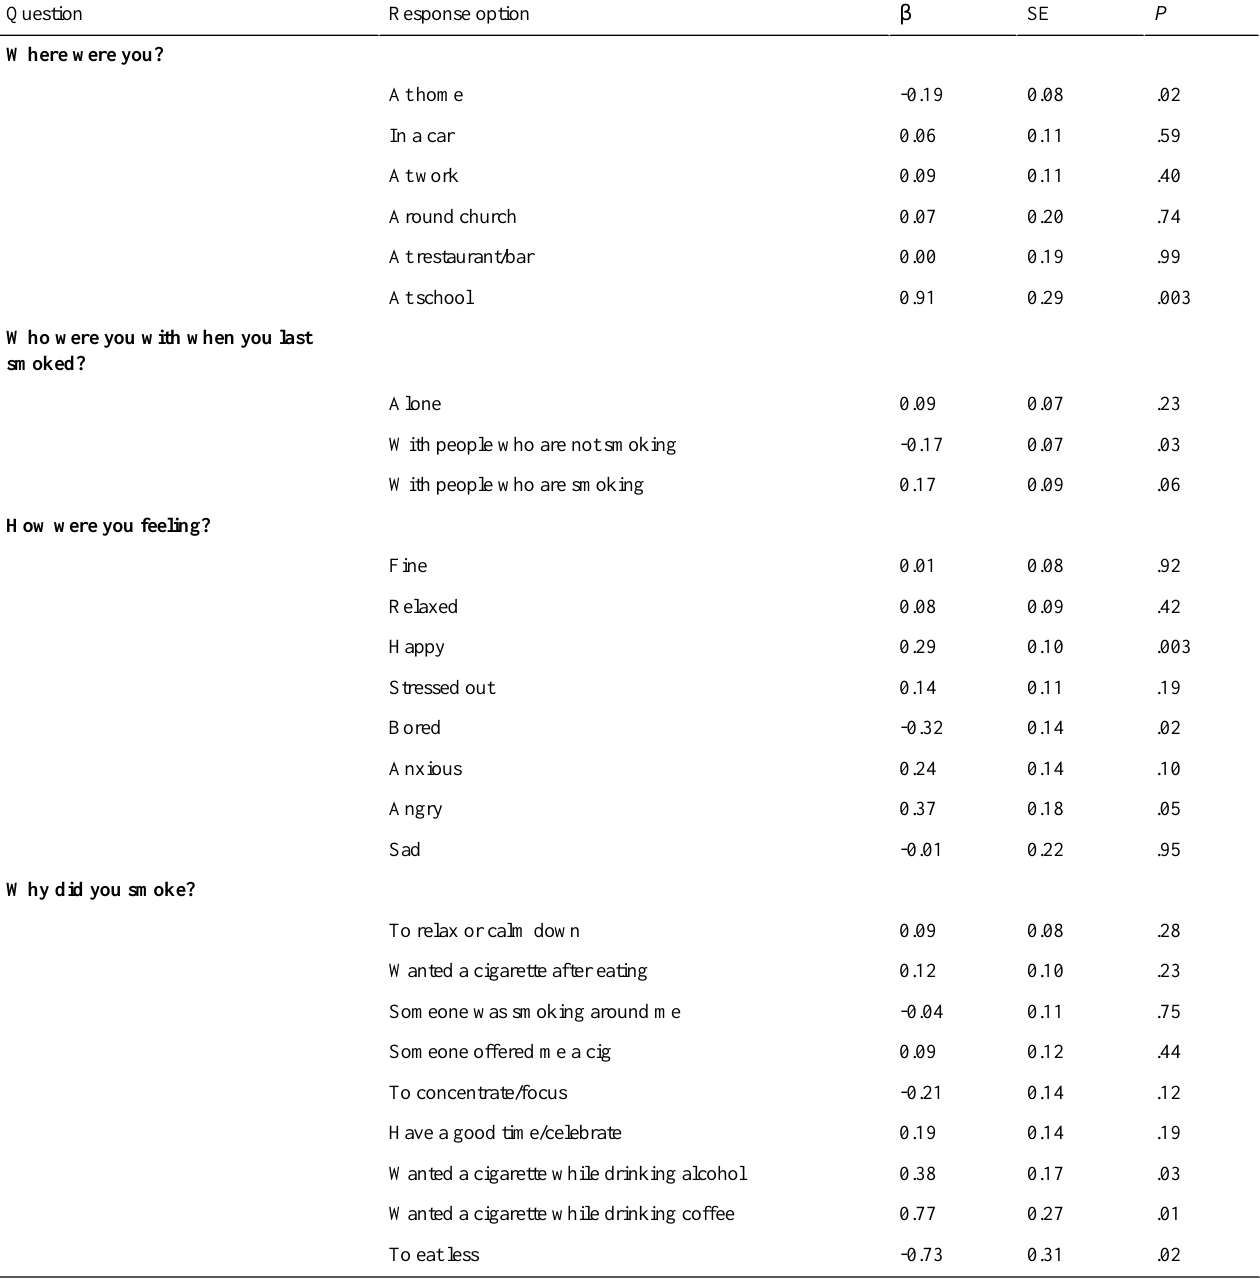
P SE β Response optionQuestion